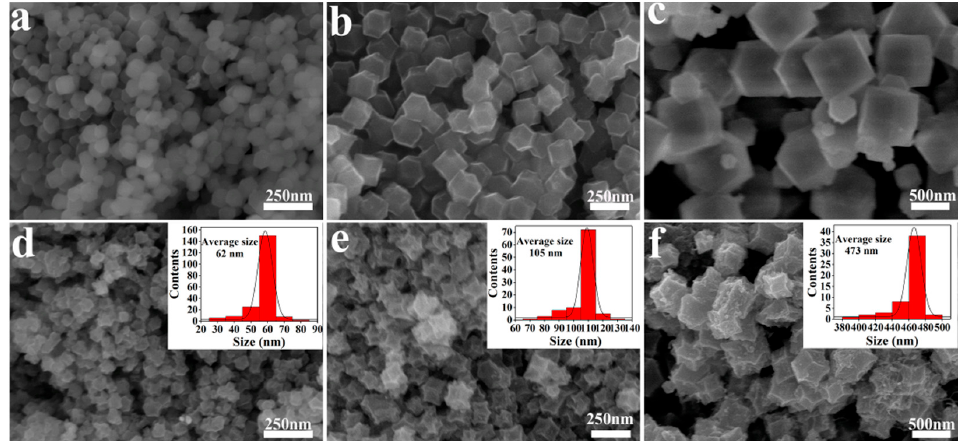
Figure 2. The SEM images of precursors ( a ) Fe–ZIF–0.025, ( b ) Fe–ZIF–0.05, ( c ) Fe–ZIF–0.075 and their carbonized products at 900 °C, ( d ) Fe–N/C–0.025–900, ( e ) Fe–N/C–0.05–900, and ( f ) Fe–N/C–0.075–900.